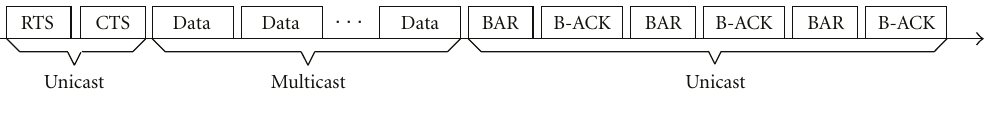
Figure 2: ELBP burst structure (3 ACK-leaders).